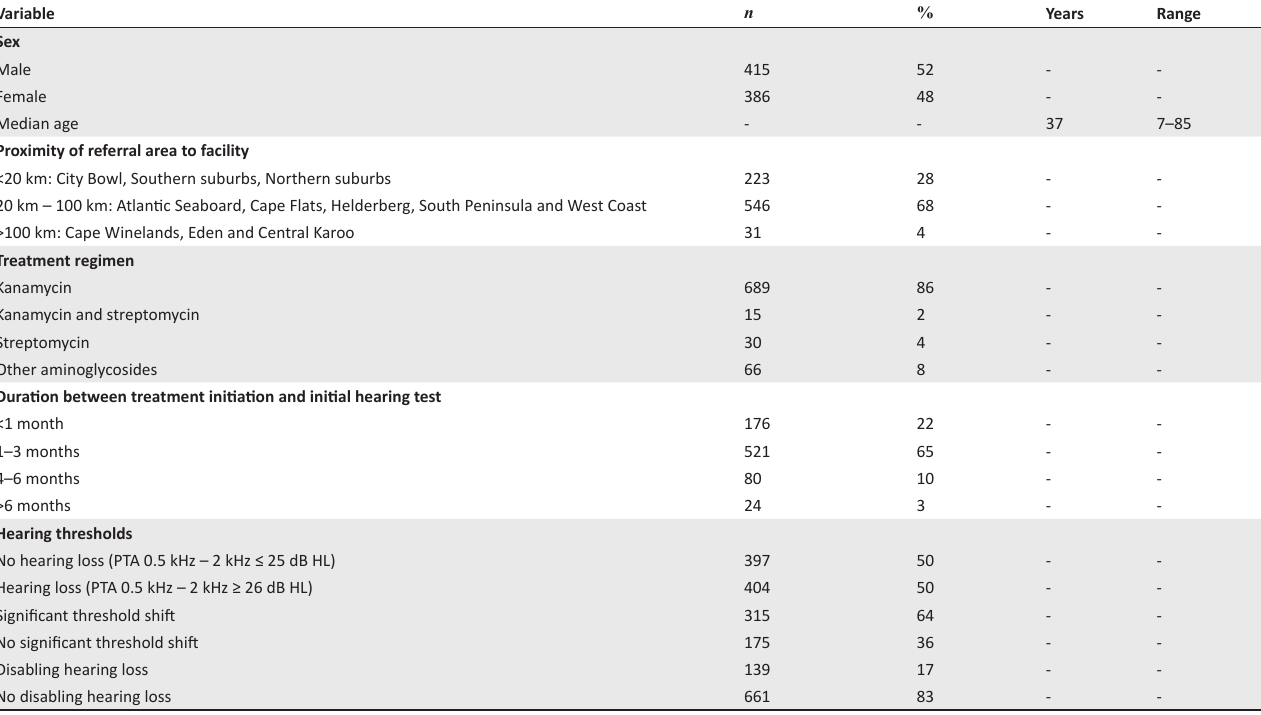
TABLE 1: Summary of patient description ( n = 801). Variable